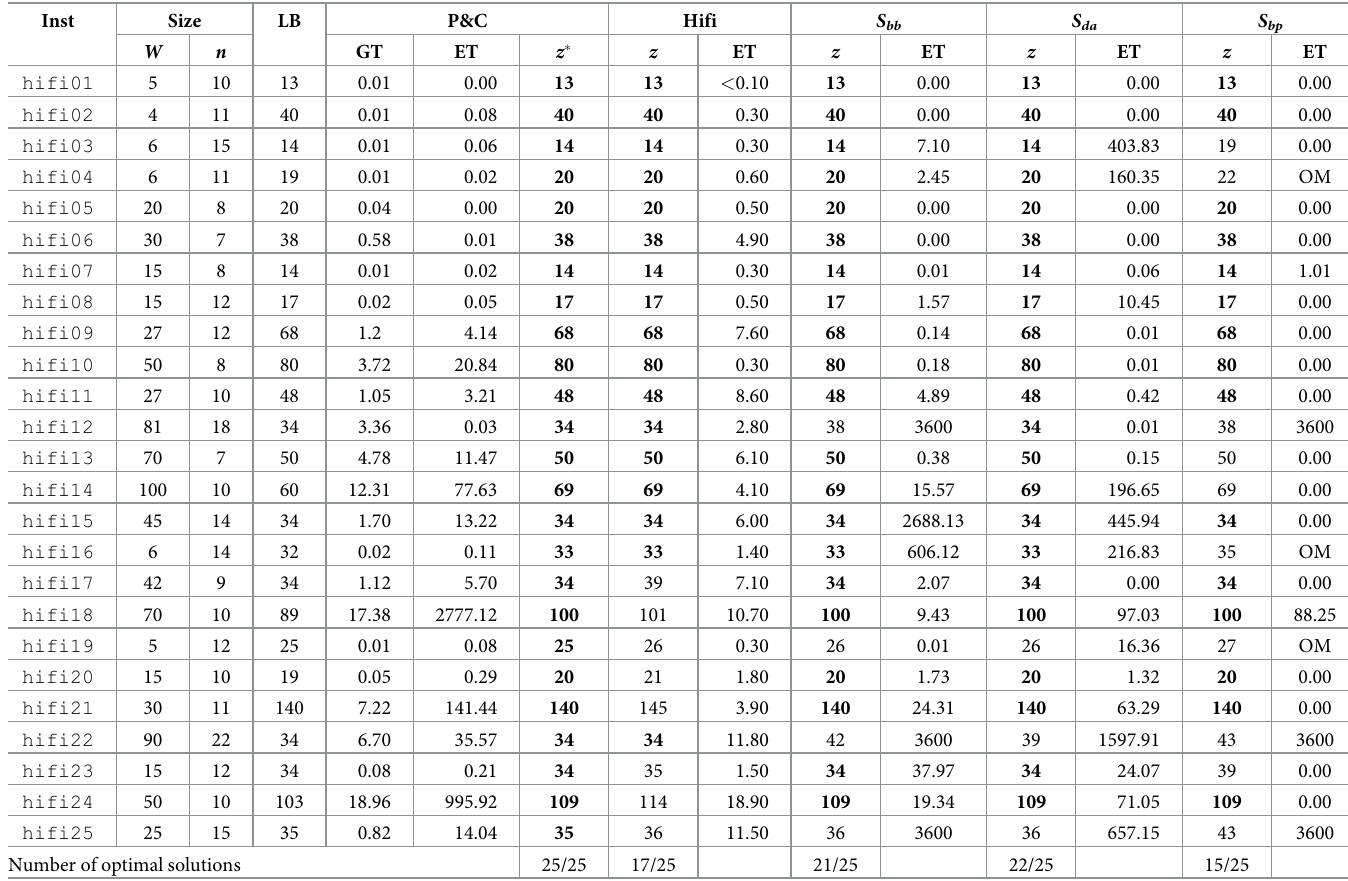
Table 4. Results for hifi instances.